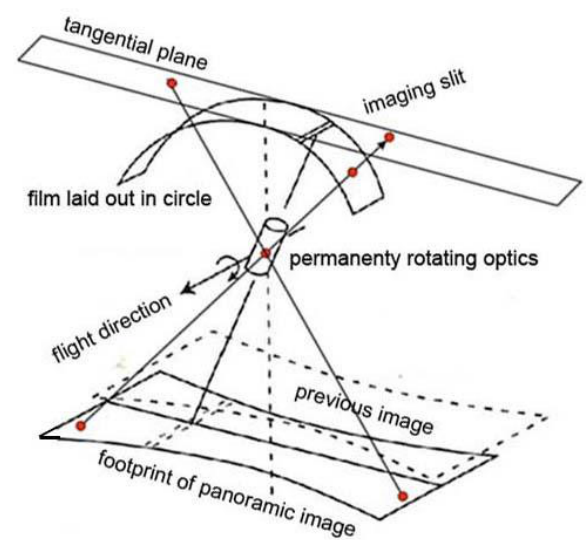
Figure 6. configuration of sub-images